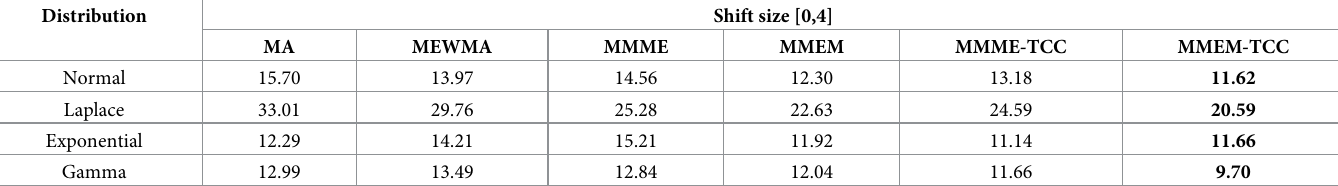
Table 7. Comparison of EARL values for a moderate to large shift size of the charts’ performance. Distribution Normal Laplace Exponential Gamma